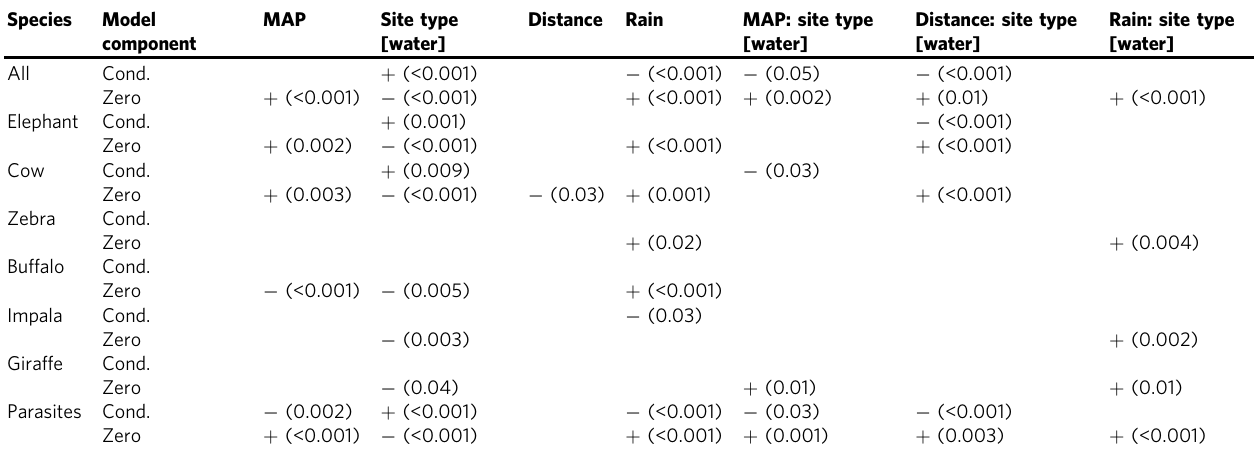
Table 2 Signi fi cant fi xed-effect coef fi cients for hurdle GLMM models of dung and parasite density for the observational system are presented for the conditional and zero-in fl ation model ( “ Cond ” and “ Zero ” ). Species Model component